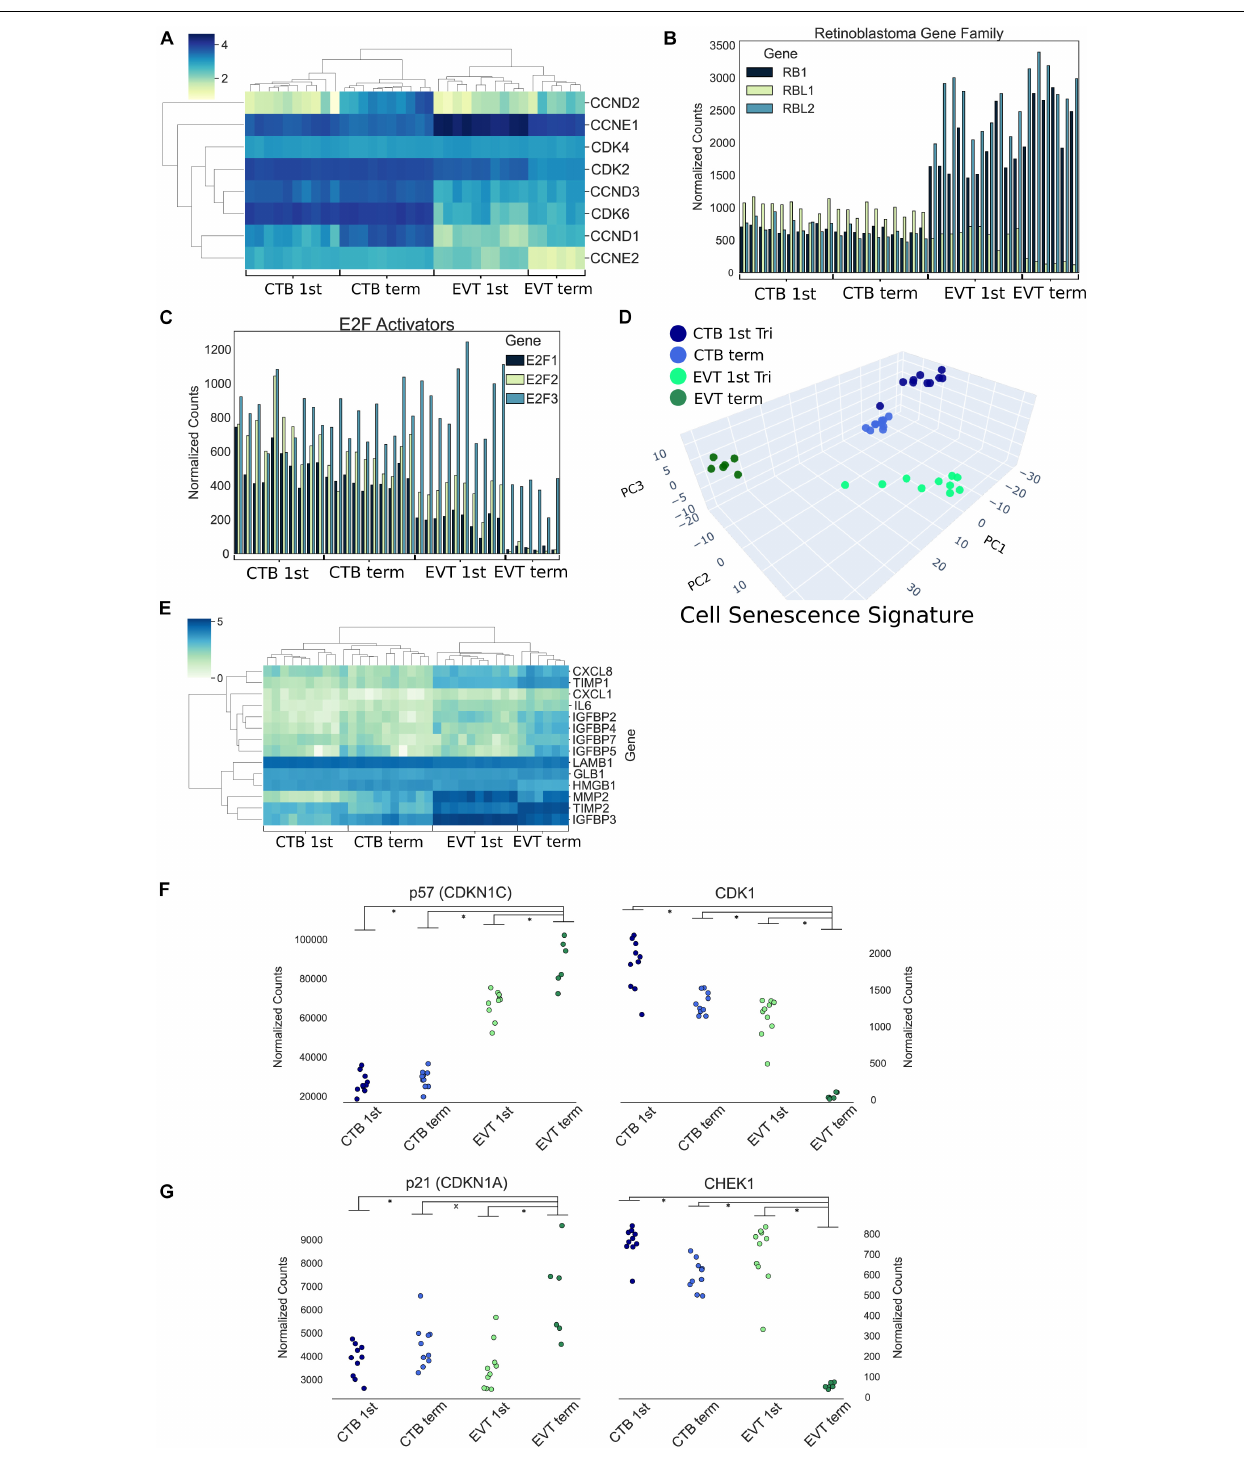
Frontiers in Cell and Developmental Biology |